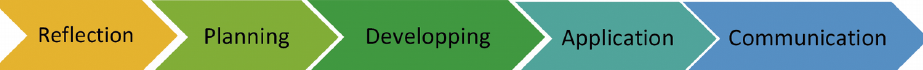
Figure 2. Five step STEAM project integrated mobile technology for elementary